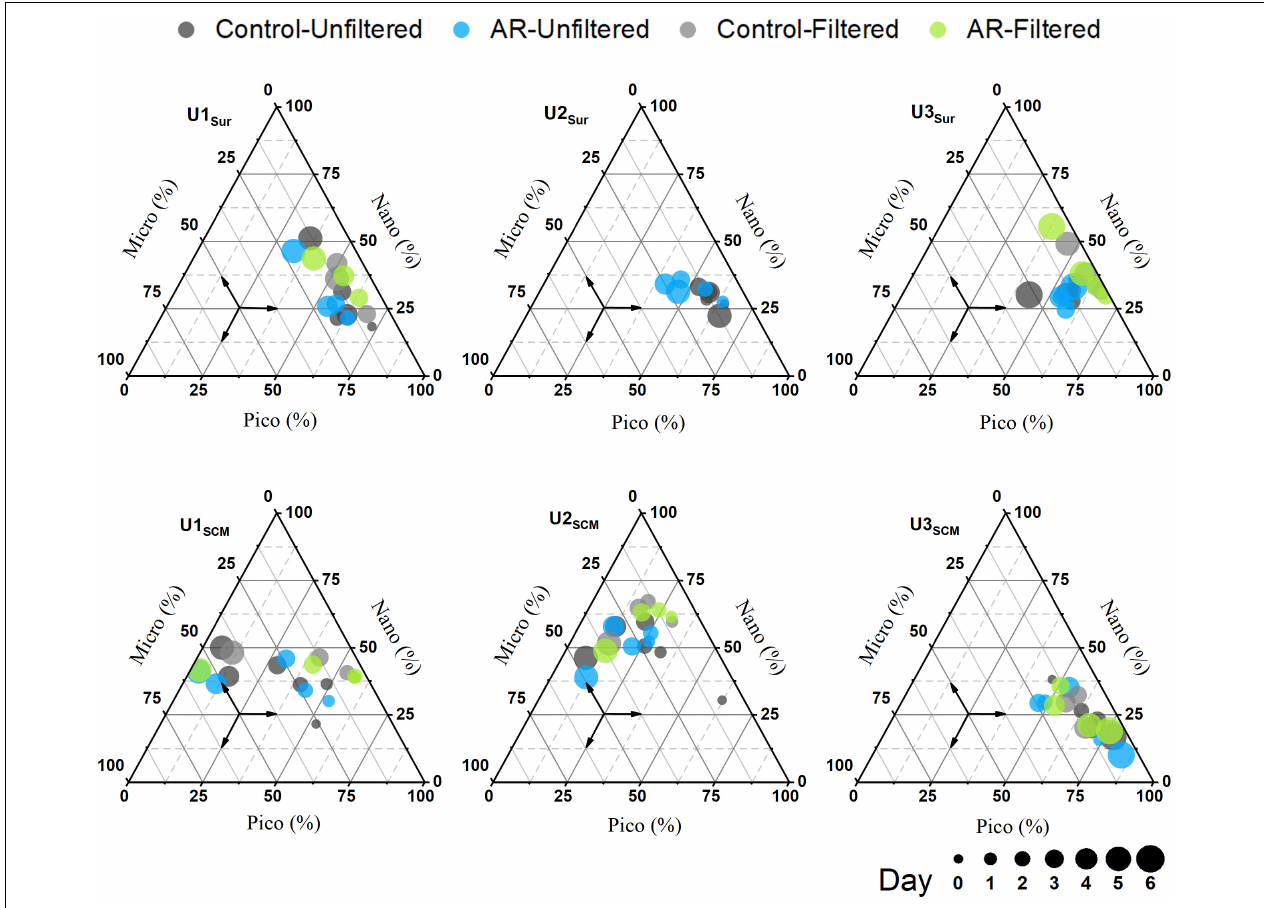
FIGURE 5 | Changes in size structure of phytoplankton in the control and AR treatments incubated with surface and SCM